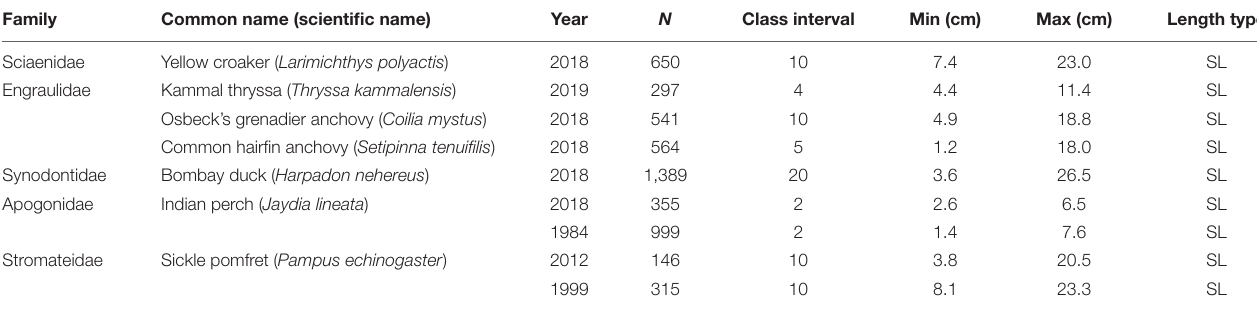
TABLE 1 | Basic information for the seven studied fish stocks. Family Common name (scientific